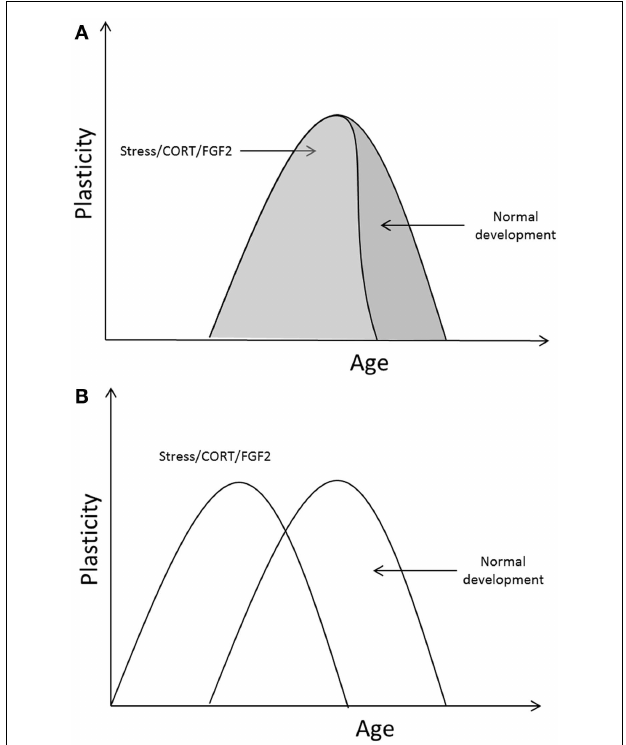
FIGURE 1 |Two potential outcomes of the effect of stress/CORT/FGF2 on critical period timing in the emotion system . (A) Different manipulations may alter the duration of the critical period but may not affect the age at opening. (B) Once opened, the duration of the critical period may be relatively static; manipulations causing an early opening of the critical period in emotional plasticity would also cause an early